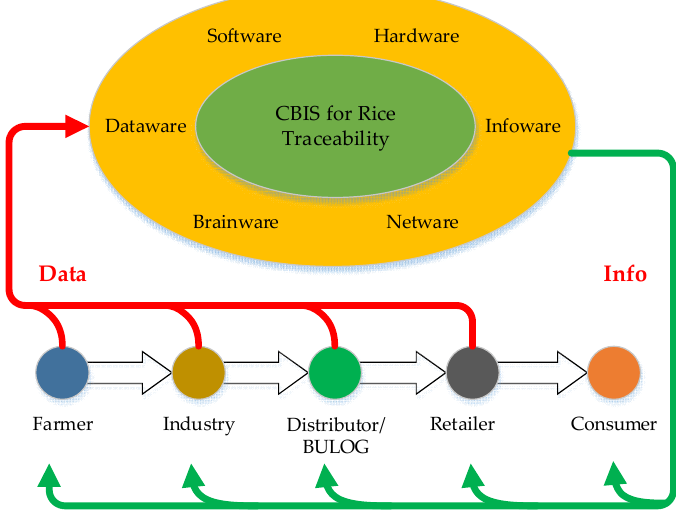
Figure 8. Computer-based information system (CBIS) for traceability system. Modified from Figure 8. Computer‐based information system (CBIS) for traceability system. Modified from Seminar [41]. Seminar